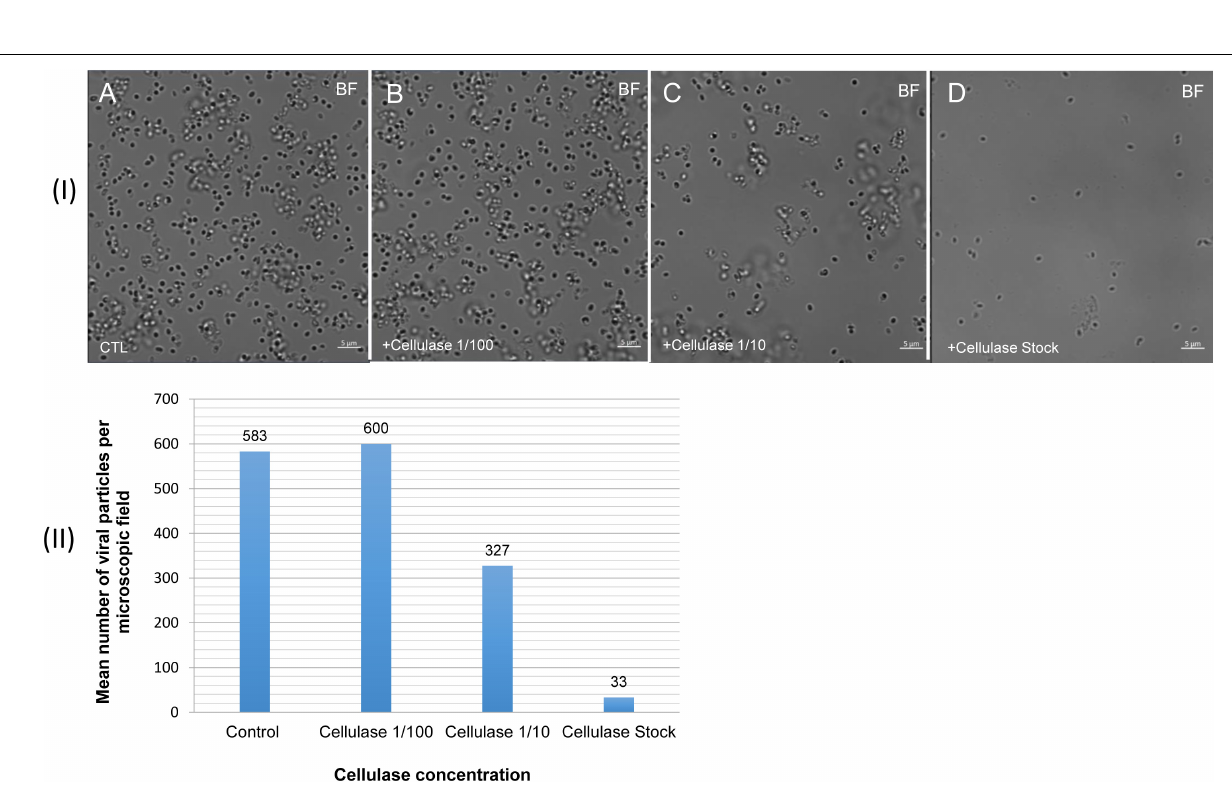
FIGURE 7 | Confocal imaging of cellulase-treated P. massiliensis (I) and estimation of the mean number of particles of P. massiliensis per microscopic field of observation after cellulase treatment (II) . (IA) Control condition with untreated P. massiliensis particles. (IB–ID) : cellulase-treated P. massiliensis particles. (II) The mean number of particles of P. massiliensis per microscopic field of observation after cellulase treatment was assessed by the ImageJ software.